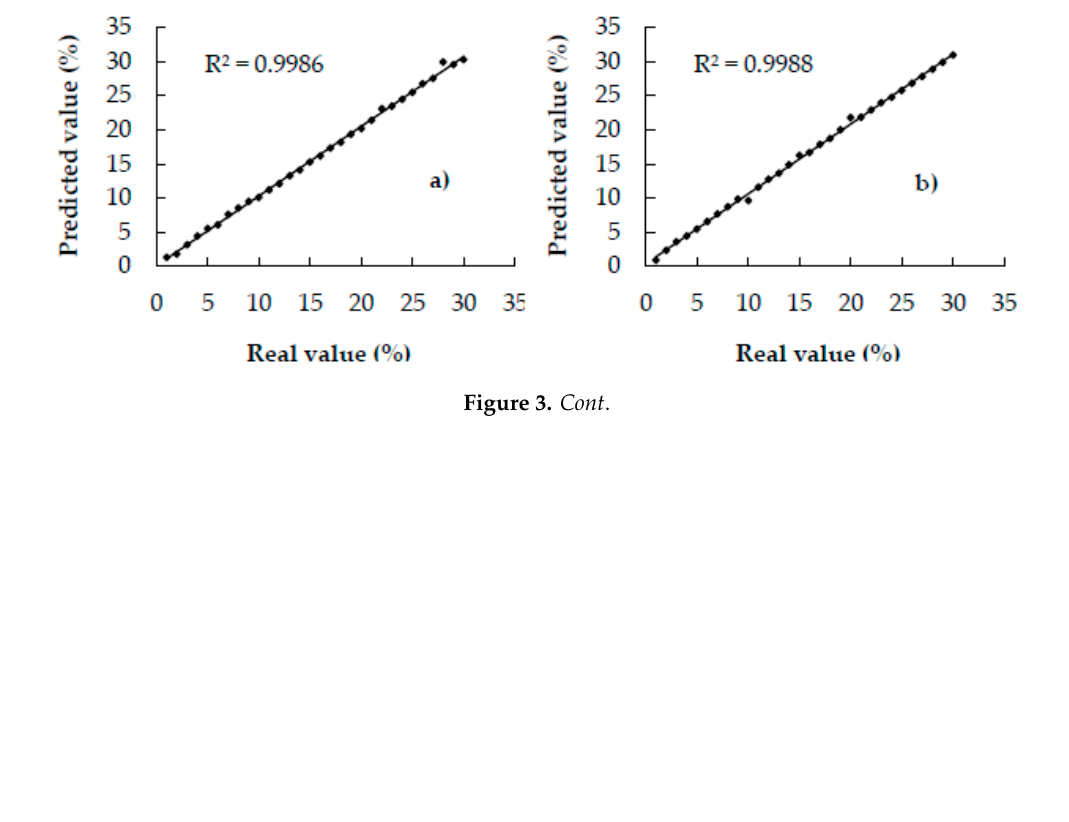
The algorithm with the best predictive results is highlighted in italics and bold. a Factors, b R 2 c (coe ffi cient of determination of calibration, must be close to 1), c SEC (standard error of calibration, should be as low as possible),